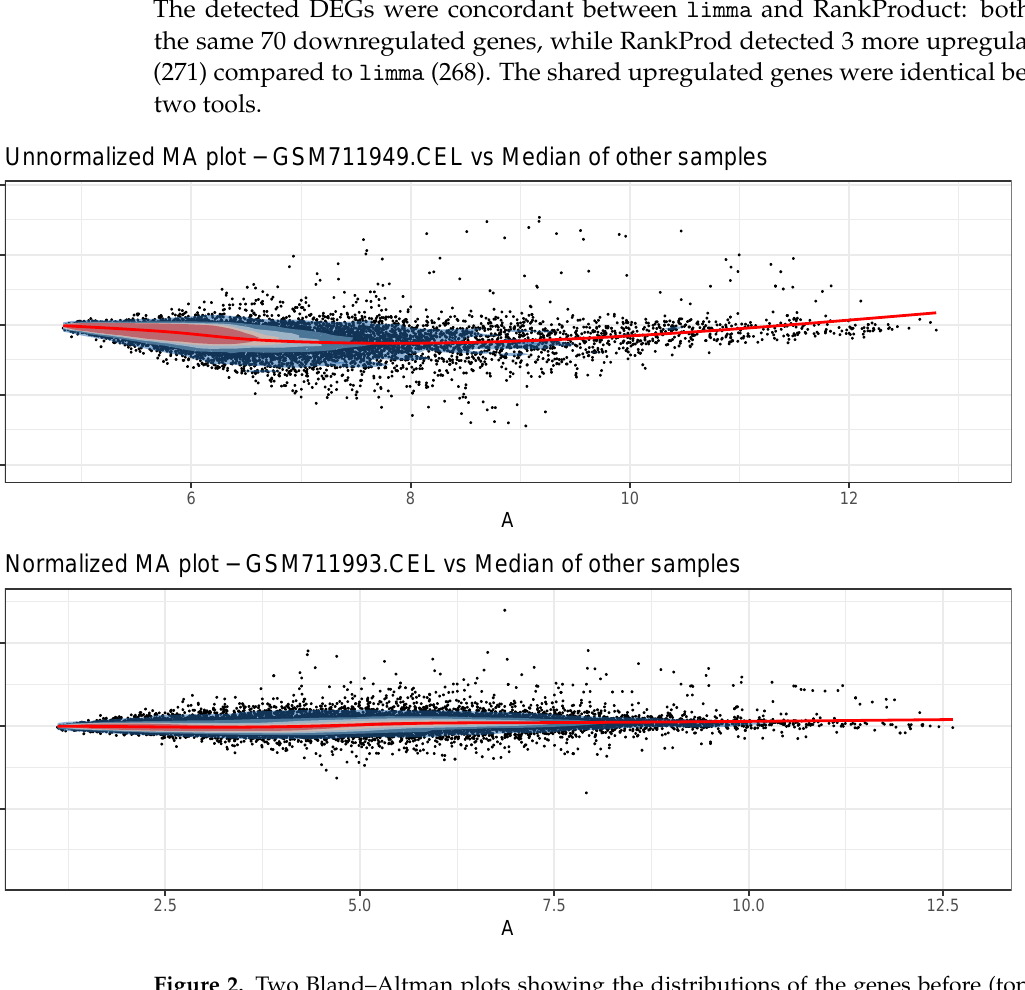
Figure 2. Two Bland–Altman plots showing the distributions of the genes before (top) and after (bottom) normalization procedures. Data taken from the Zhang data